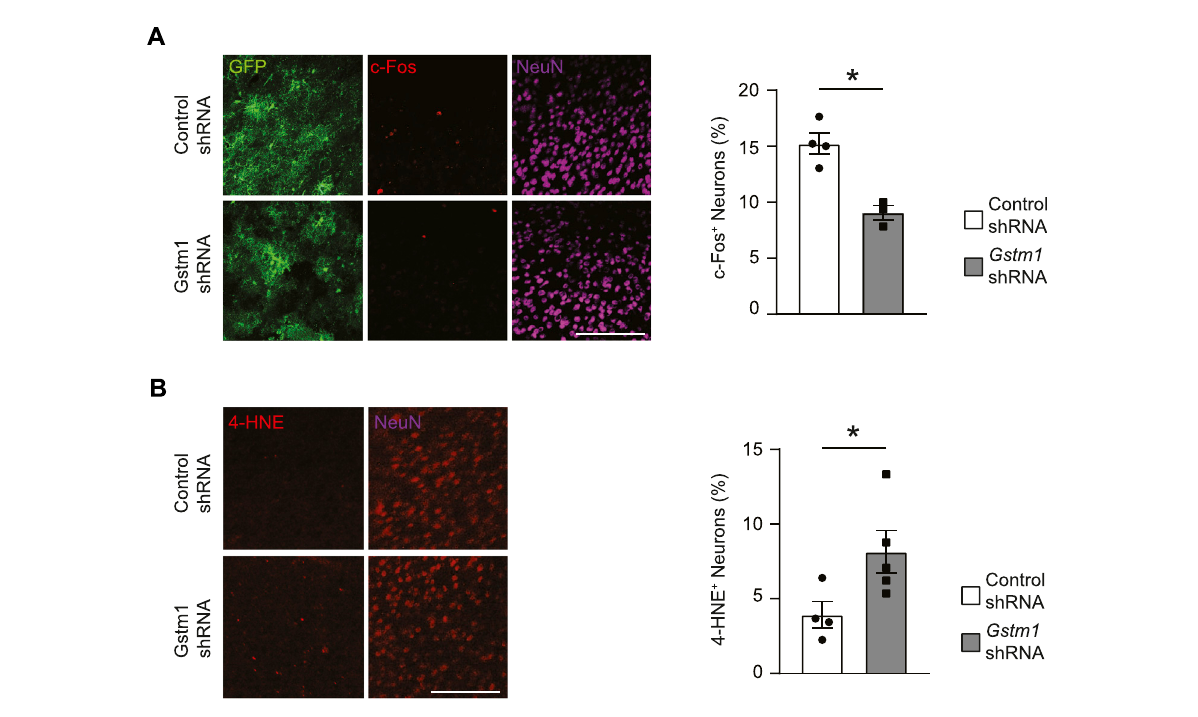
FIGURE 2 Reduced activities and enhanced cellular stress in neurons associated with GSTM1 KD astrocytes in the brain. Mice with astrocyte-speci fi c expression of Gstm1 or control shRNA were subject to LPS-induced brain in fl ammation. The brains were collected at the peak of in fl ammation (6 h afterasystemicLPSinjection).c-Fosexpressionwasmeasuredasmarkerofneuronalactivities (A) andlevelsoflipidhyperoxidation(4-HNEstaining) were evaluated as cellular stress maker (B) . Percentages of c-Fos + NeuN + cells and 4-HNE + NeuN + cells were quanti fi ed and compared between Gstm1 or control shRNA conditions. Graphs show mean ± SEM. Scale bar: 100 µm Control shRNA, n = 4; Gstm1 shRNA, n = 3 – 5. Signi fi cance was determined by t -test. * p <